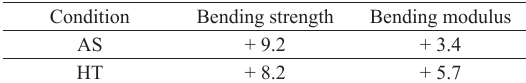
Table 3. The relative ratios (%) of bending strength and bending modulus of Ti15Sn versus Ti15Sn2Cu alloy.